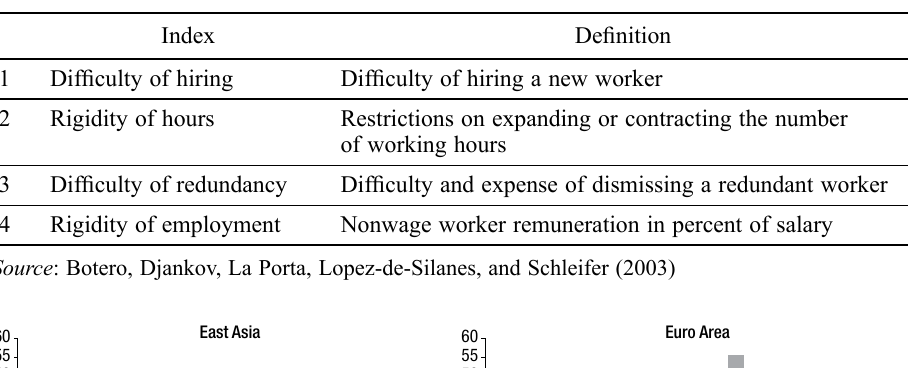
Table 2. Employing workers index